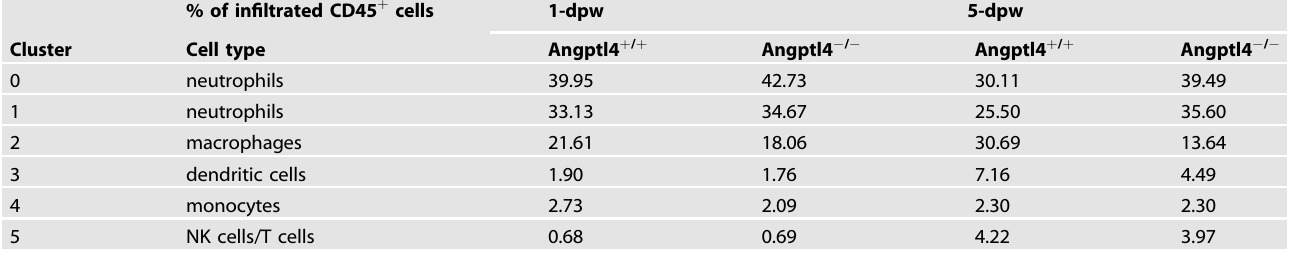
Table 2. I mmune cell subpopulations in Angptl4 + / + and Angptl4 − / − wounds by